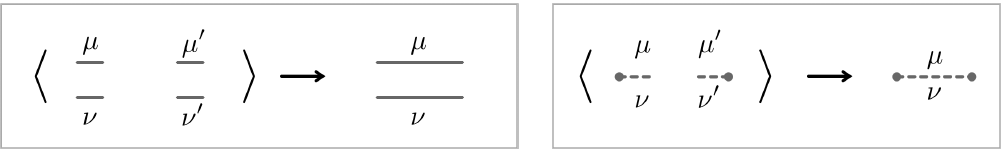
Figure 4: Alternative ways of representing building blocks of matrix theories. Left: double line notation customary in matrix field theory. Right: ‘impurity diagram rep- resentation’ customary in the physics of random